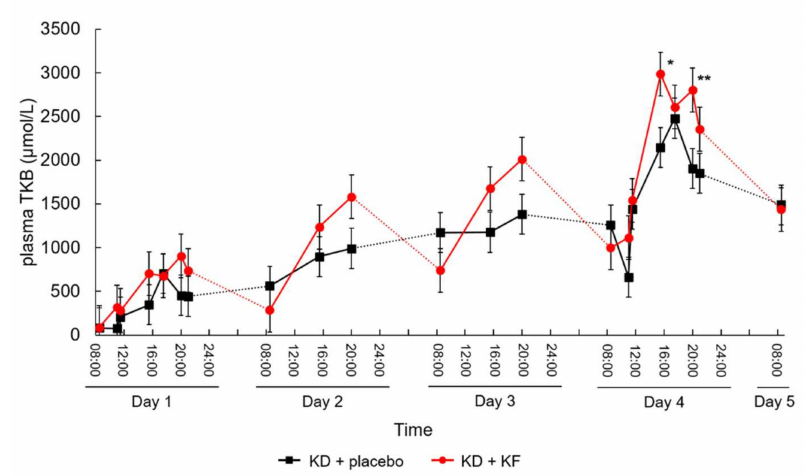
Figure 4. Changes in plasma TKB concentration over time. Subjects ingested the test meal at 9:00 a.m., 1:00 p.m. (13:30), and 6:00 p.m. (18:00) each day, and their blood was collected before and 2 h after ingesting the test meals. Values are presented as least square mean ± standard error. *: p < 0.05, **: p < 0.01, vs. KD + placebo group.